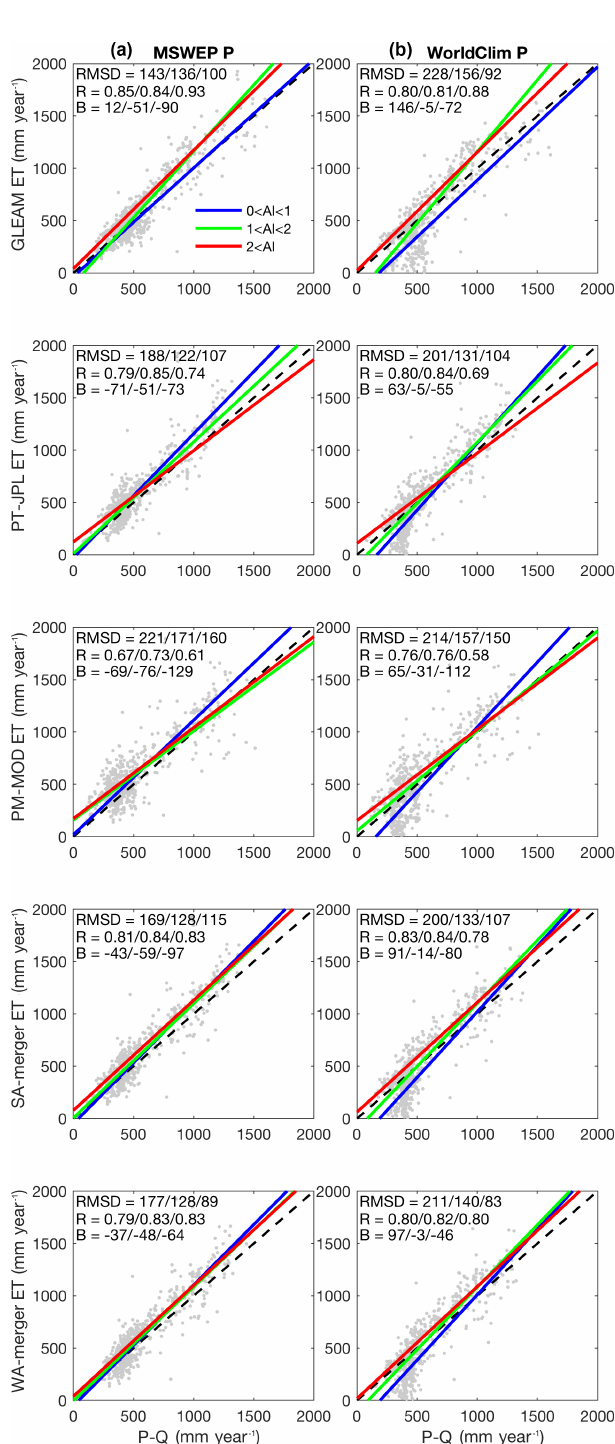
Figure 14. Scatter plots of P − Q and ET from the different prod- ucts. Linear fits for three AI classes are plotted, together with the correlation, RMSD, and bias (ET – ( P − Q )). From left to right, the statistics are given for AI < 1 (blue line), 1 < AI < 2 (green), and AI > 2 (red), i.e. from dry to wet